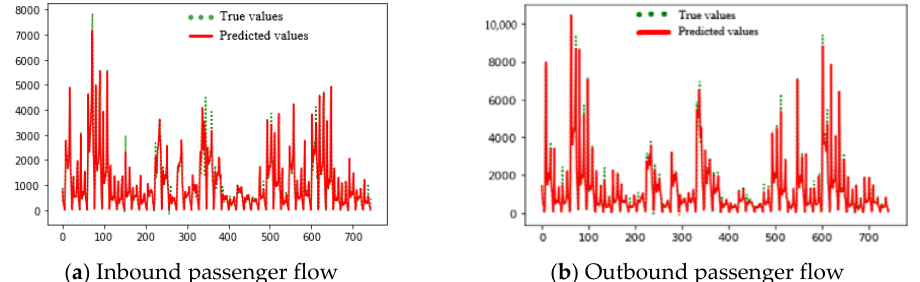
Figure 13. Prediction results of short-term passenger flow based on LSTM model.